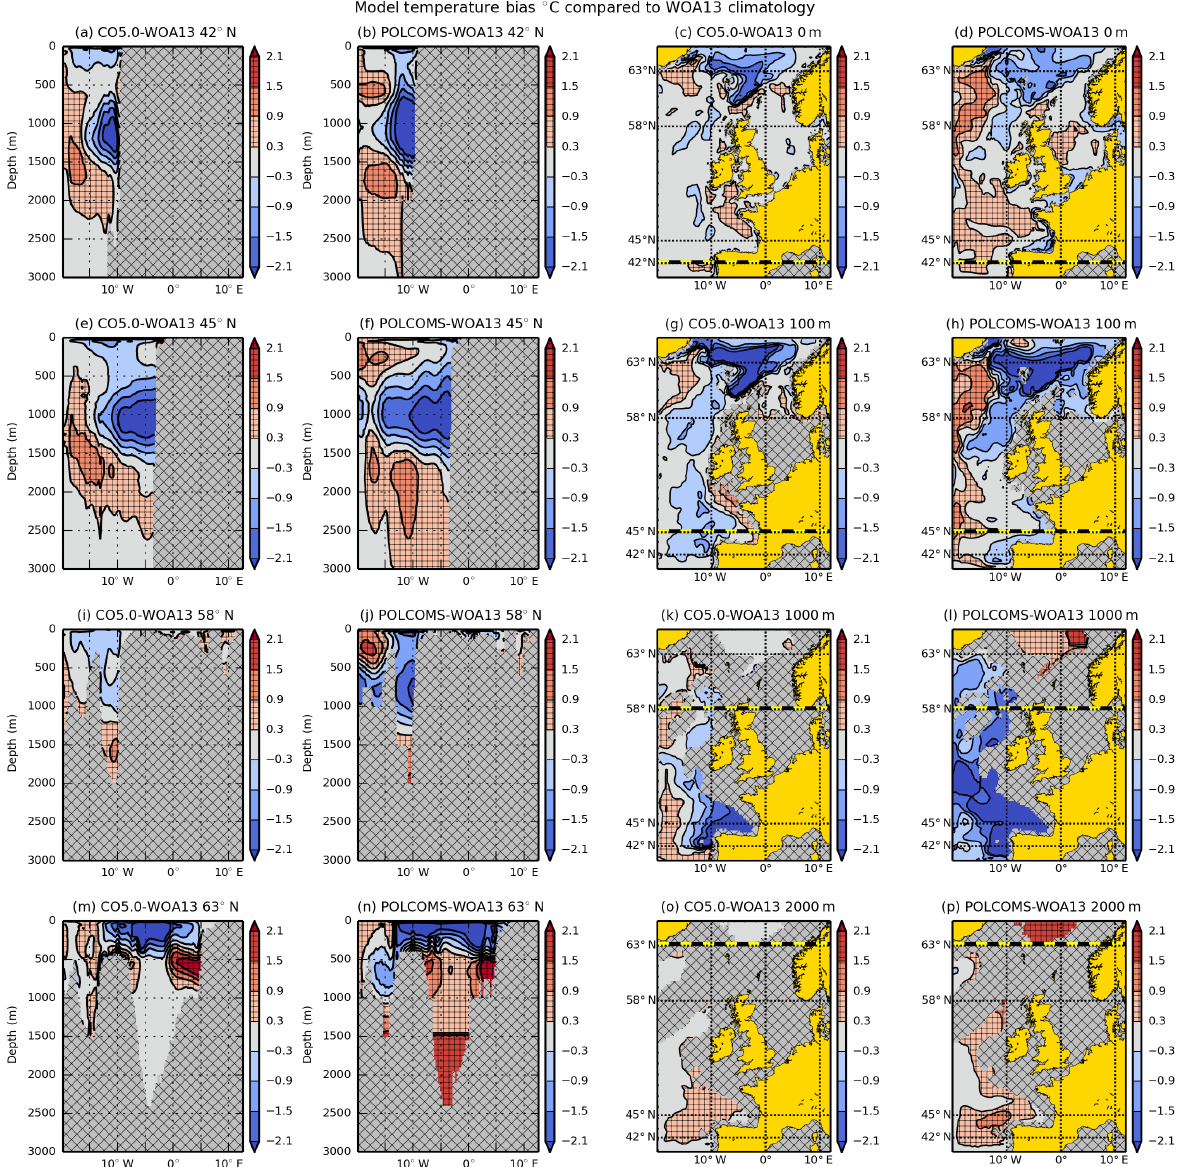
Figure 8. CO5 and POLCOMS temperature bias compared to WOA13 1985–2005. Panels (a) , (e) , (i) and (m) are CO5 – WOA13 temperature bias transects along 42, 45, 58 and 63 ◦ N. Panels (b) , (f) , (j) and (n) are POLCOMS – WOA13 temperature bias transects along 42, 45, 58 and 63 ◦ N. Panels (c) , (g) , (k) and (o) are the CO5 – WOA13 temperature bias at depths 0, 100, 1000 and 2000m. Panels (d) , (h) , (l) and (p) are the POLCOMS – WOA13 temperature bias at depths 0, 100, 1000 and